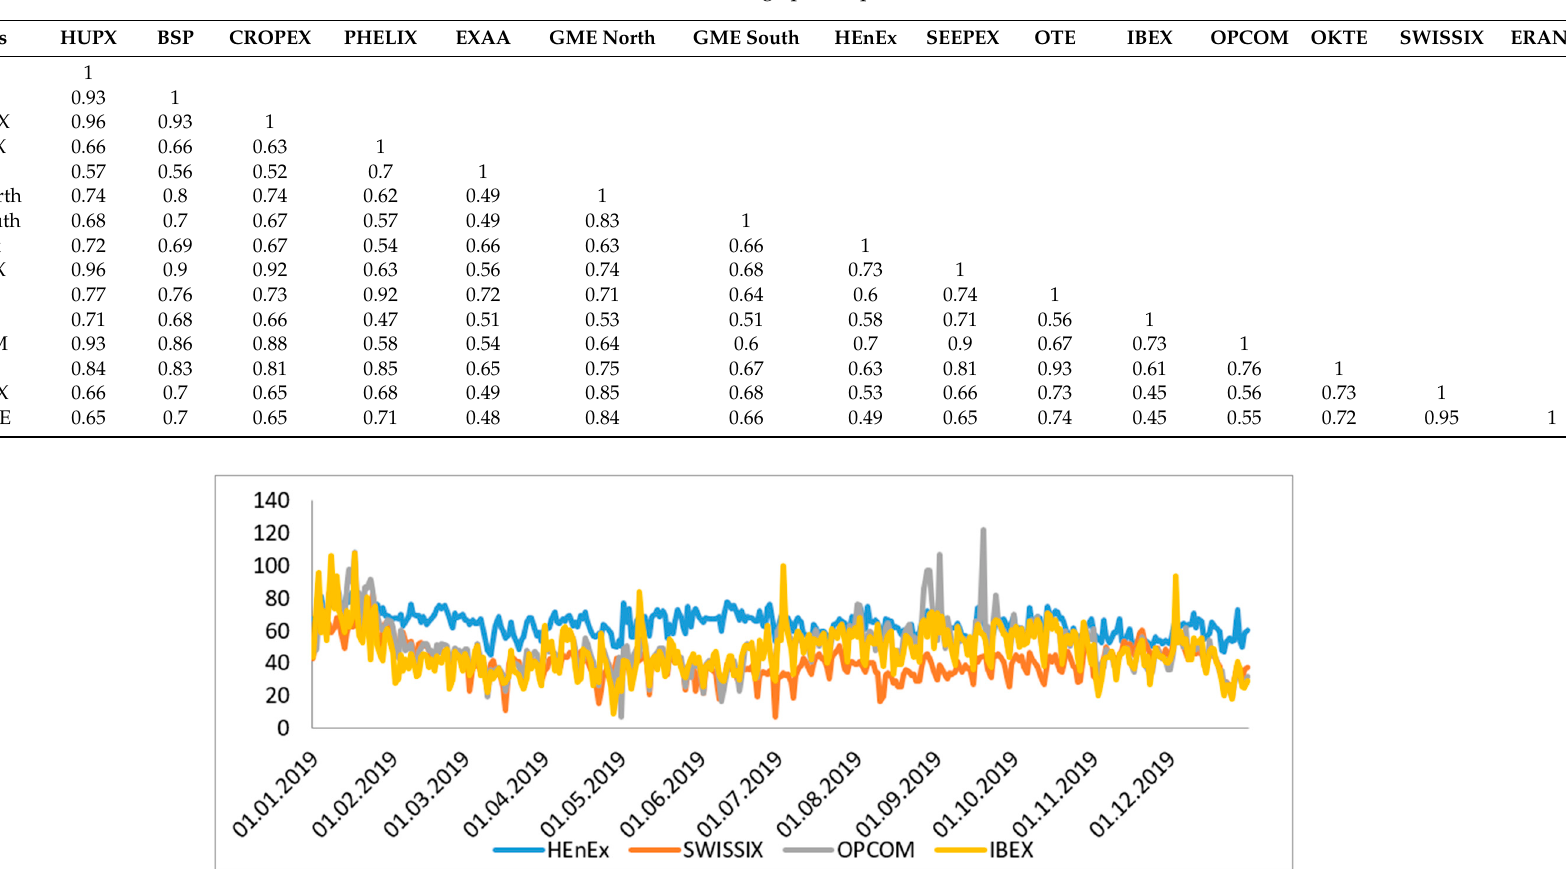
Table 4. Correlation matrix of average power prices between markets.